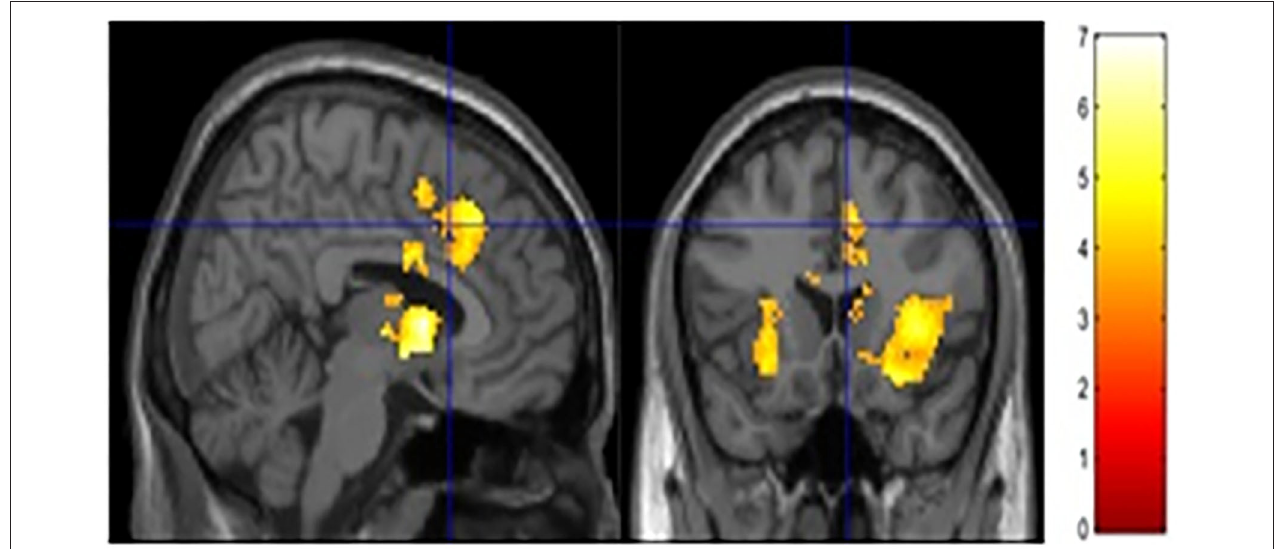
FIGURE 2 | Risk activity collapsed across groups. Significant activity was observed in the ACC, NAc and bilateral insula.